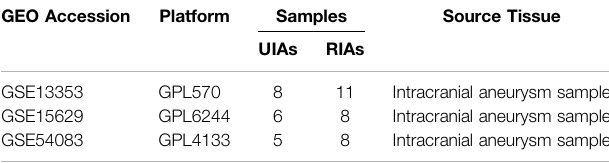
TABLE 1 | Information for selected microarray